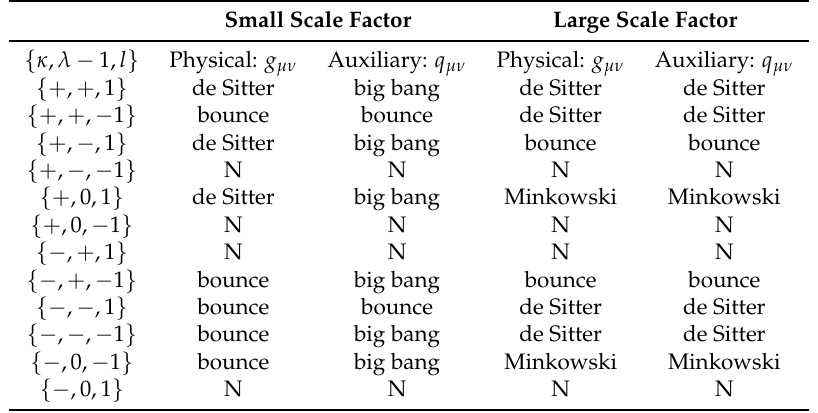
Table 1. This table summarizes the cosmological behaviors of the universe described by the two metrics, g µν and q µν , for small and large scale factors for all the possible combinations of the parameters { κ , λ , l } . For example, { + , − ,1 } corresponds to the parameter space κ > 0, λ < 1 and l = 1, and so forth. The character “N” in the table means that there is no solution for such a choice of